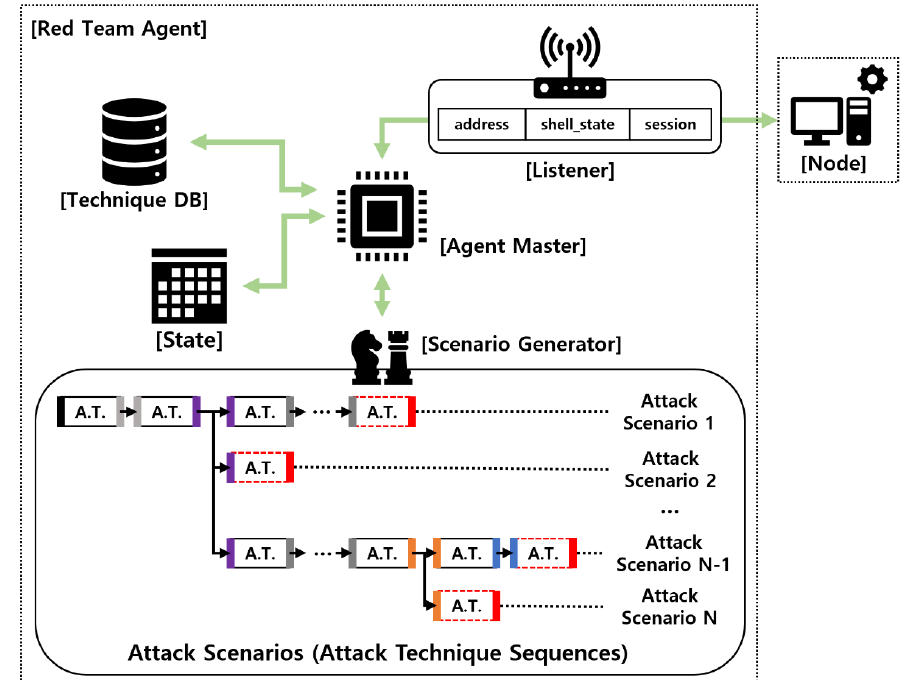
Figure 1. Overall architecture of red team